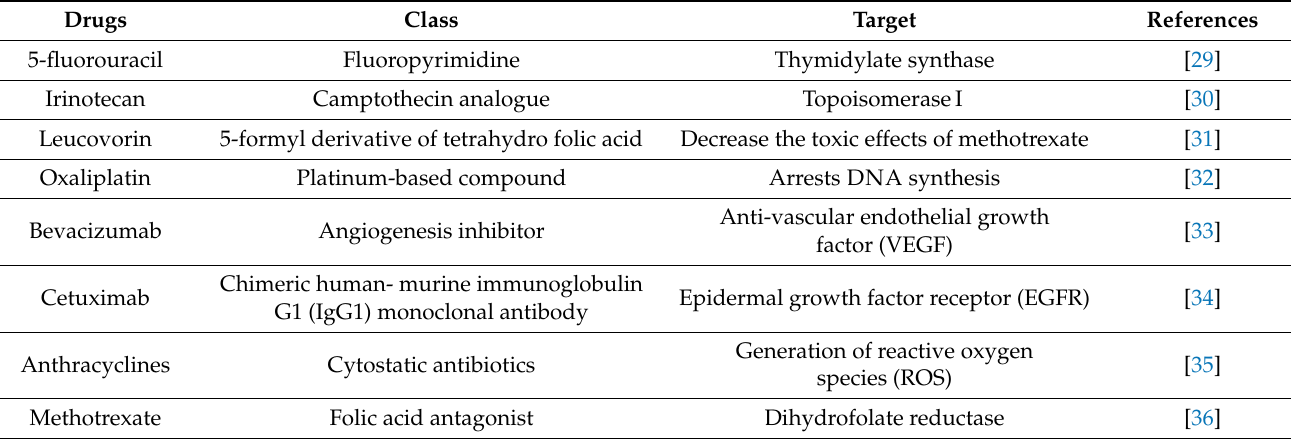
Table 1. Mechanism of action and class of various drugs in